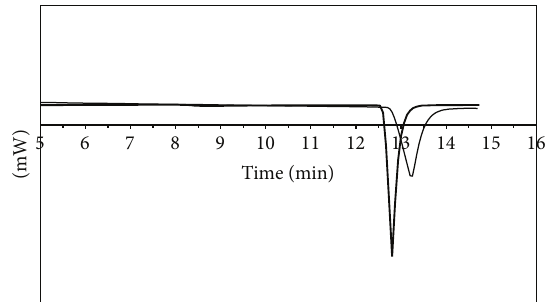
Figure 1: DSC melting peaks of In in absence (bold and sharp peak) and in the presence of PTFE 0.5 mm thick. The scan rate was 0.167 ∘ Cs −1